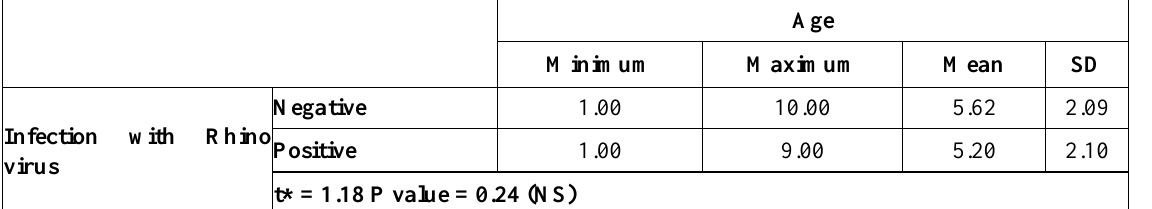
Table 4. Association of HRV detection with age.